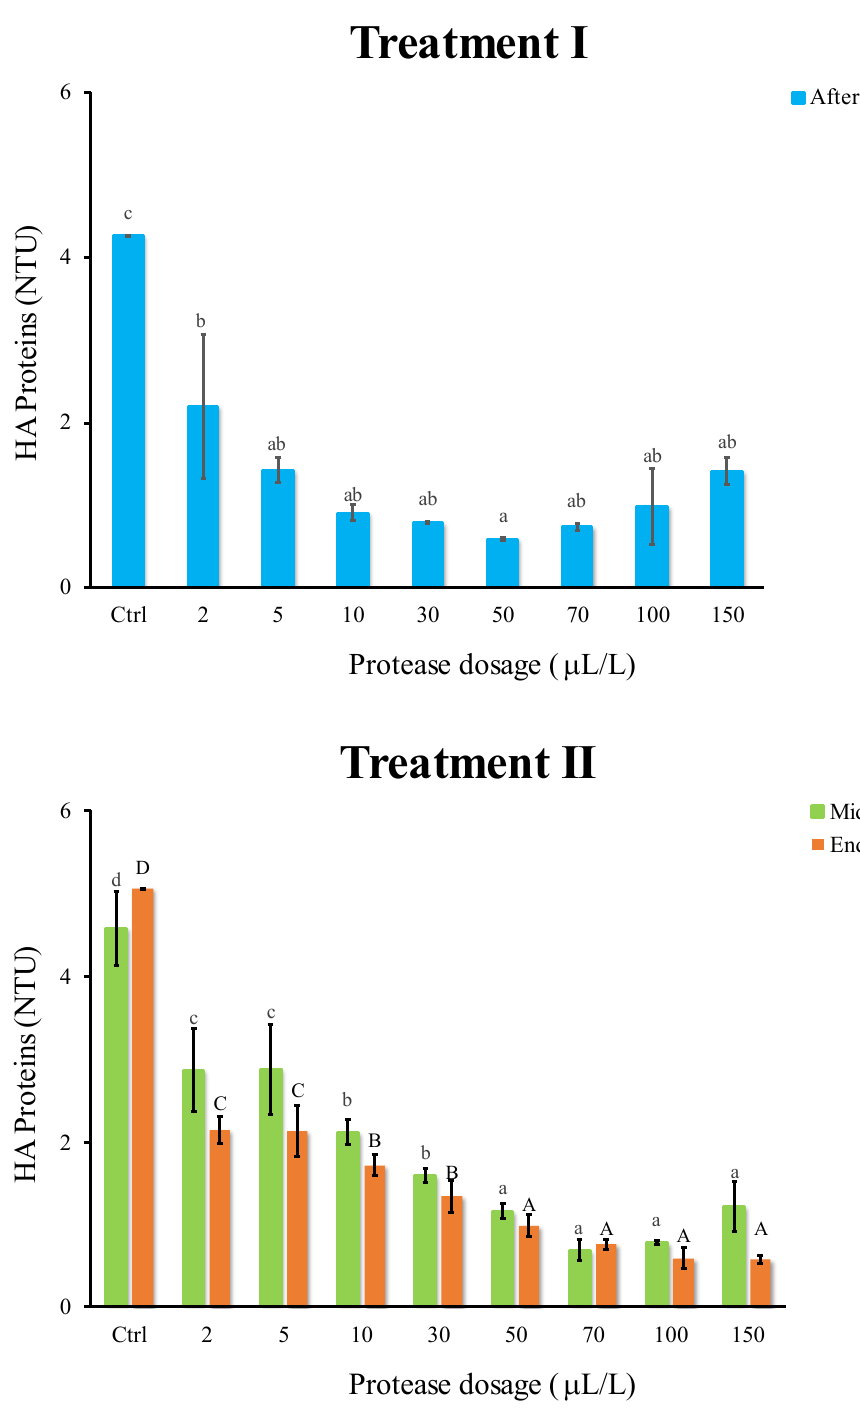
Figure 4. Haze active (HA) proteins of white must wine (NTU) subjected to enzymatic addition (protease in the range of 2–150 µ L/L) after ( a ) treatment I (cold settling prior to AF) and ( b ) treatment II (at yeast inoculum). Ctrl is clarified must with the only pectinolytic enzyme. For each sample, means with different roman letters are significantly different ( p ≤